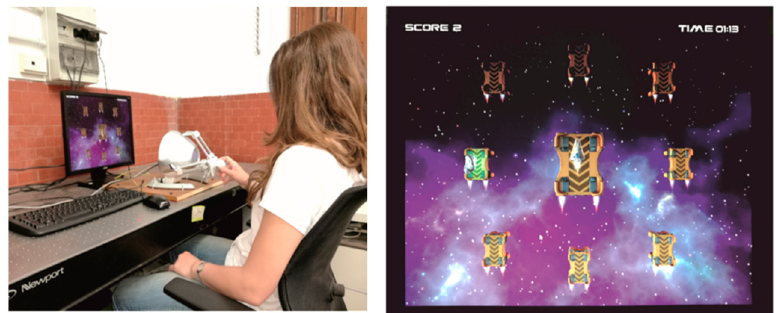
Figure 1. The game scene on the left and experimental set-up on the right.